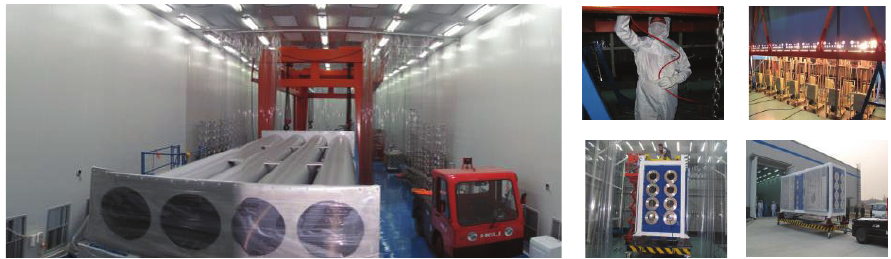
Figure 2: Small-batch production line for large mechanical structure cleaning.